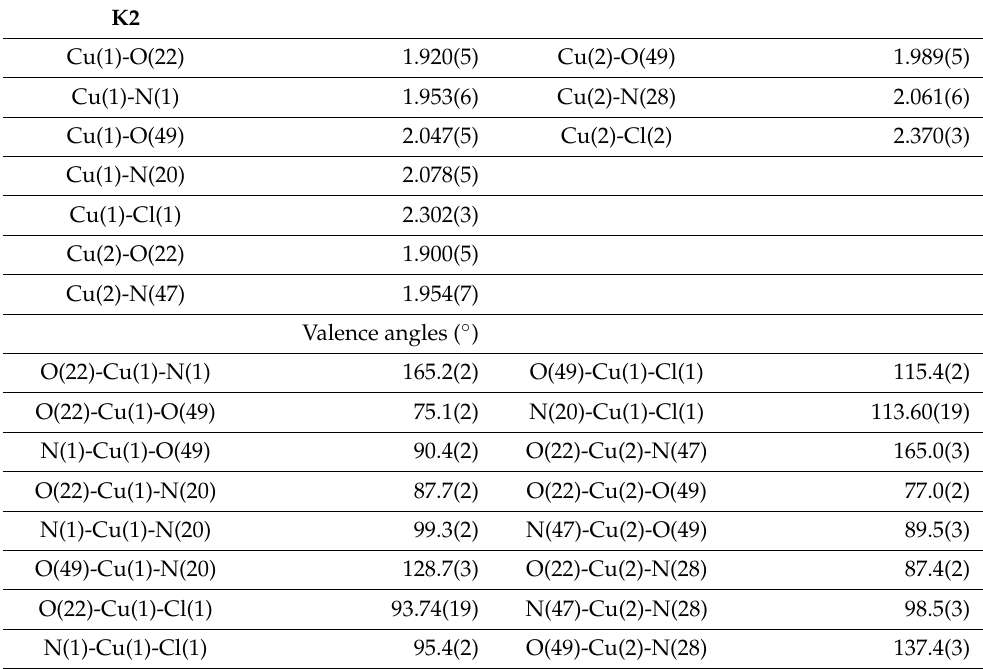
Table 2. Selected bond length (Å) and valence angles ( ◦ ) for the complex K2 .